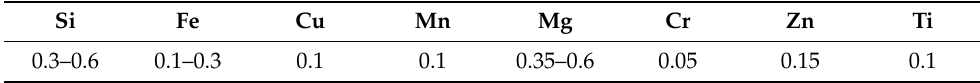
Table 1. Chemical composition of EN AW-6060 (Al balance) in weight% [23].